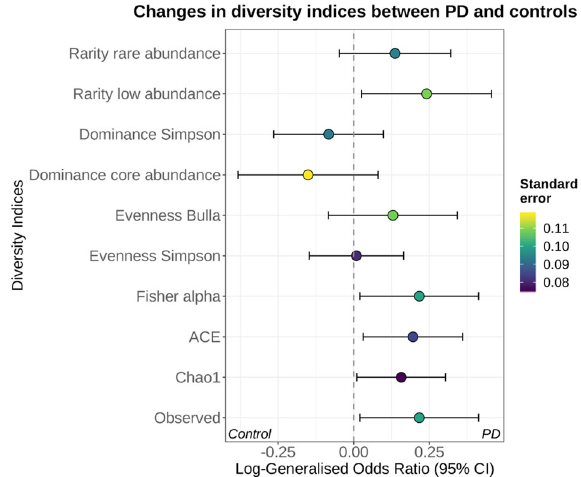
Fig. 2 Alpha-diversity indices are signi fi cantly different between PD patients and controls. Indices were calculated at the species level for each dataset. Results were then combined using a random- effect meta-analysis approach. The log-generalized Odds Ratios indicate the degree of variation of each index between controls and PD. The richness of the samples was estimated using the observed number of species and the indices Chao1, ACE, and Fisher ’ s alpha. To estimate evenness, which indicates how different the species abundances in a community are from each other, we used the Bulla and Simpson indices. Finally, we estimated dominance, which describes how much one or few species dominate the community, and rarity, which assesses the number of species with low abundance in the samples. The data suggest that the gut microbiota of PD patients is more diverse (higher richness) than controls and this is likely a consequence of an increase in rare taxa